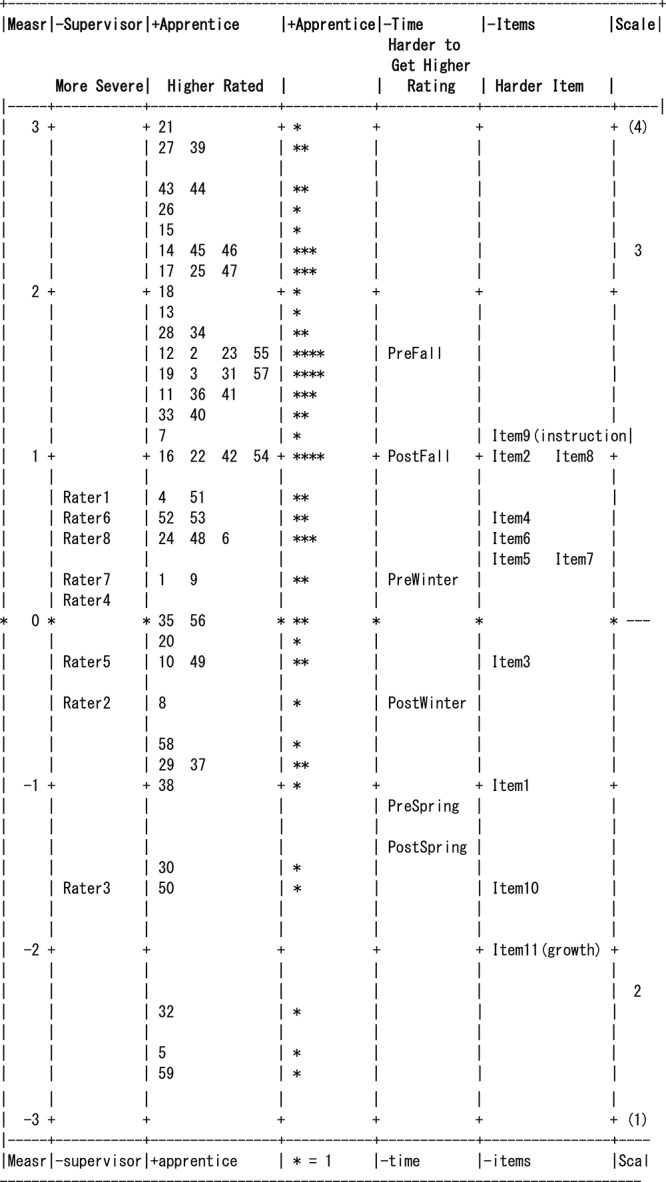
Item-person map.